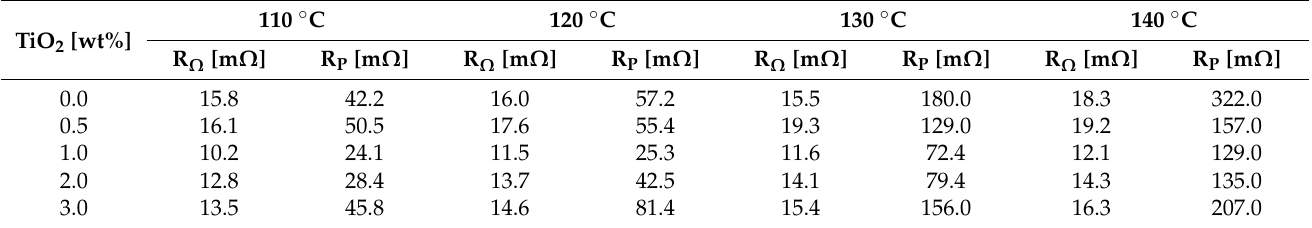
Table 2. Ohmic resistance and charge transfer resistances for the studied membranes.